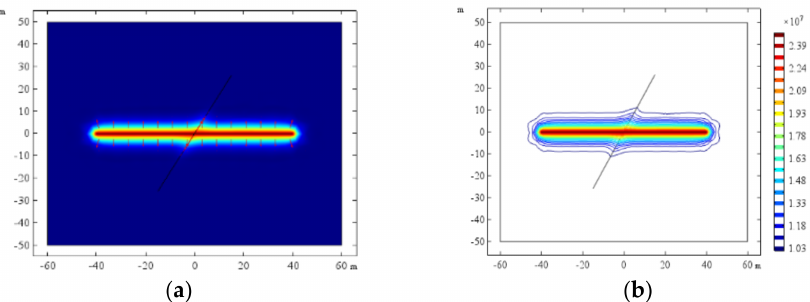
Figure 9. Case 6 calculation result. ( a ) Grout propagation pattern. ( b ) Distribution of grout propaga- tion pressure field.